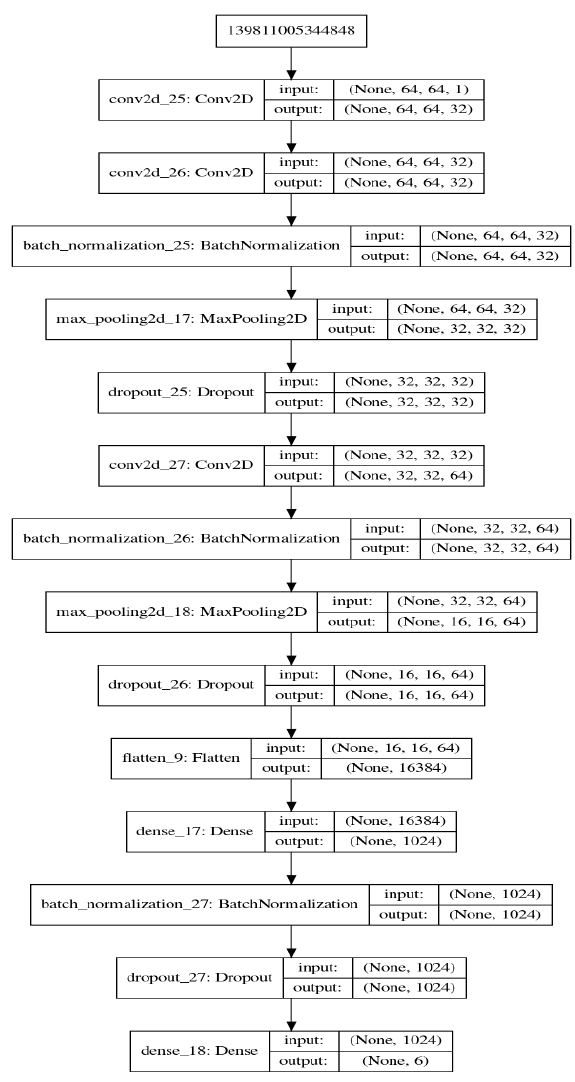
Figure 3. The structure of the proposed Deep Learning